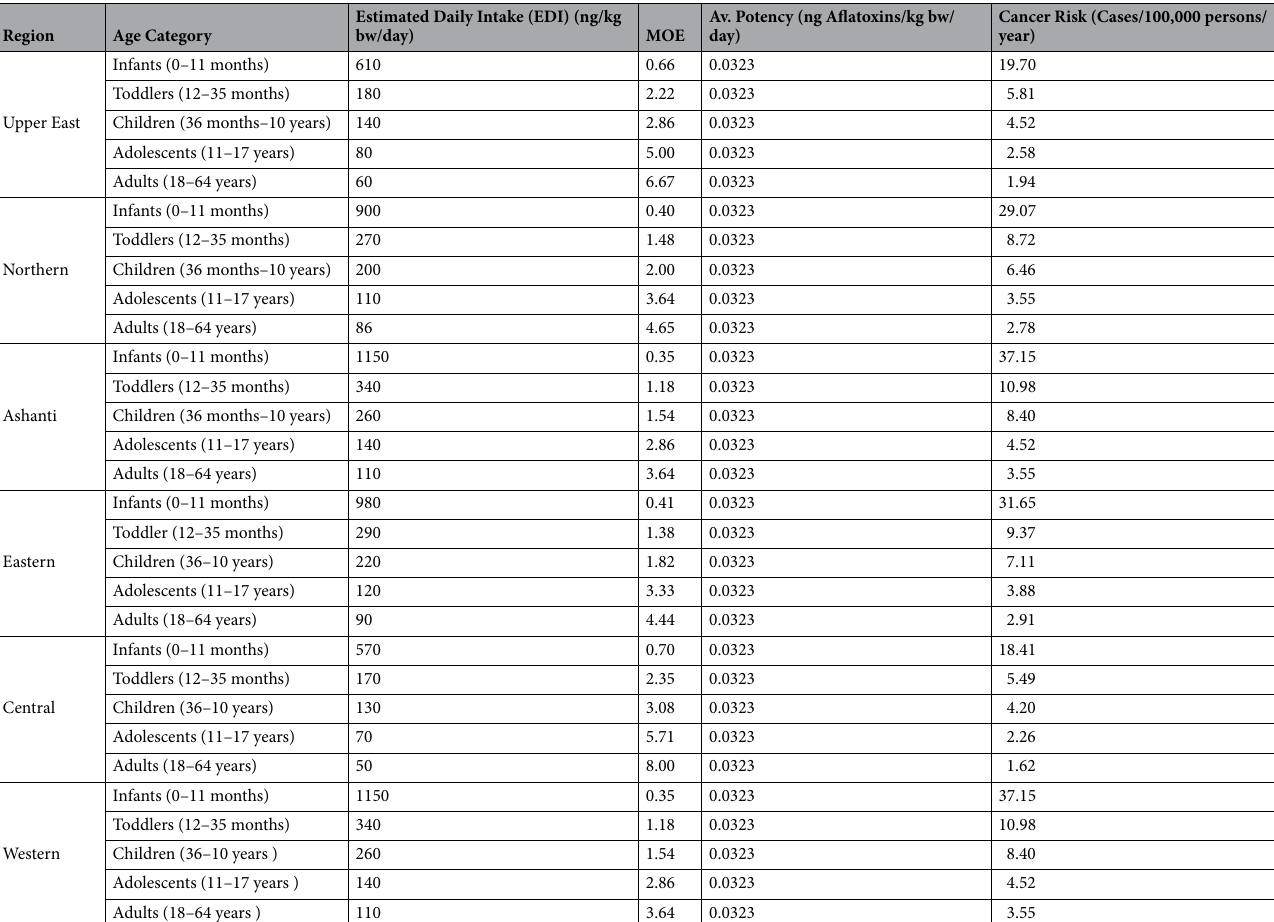
Table 16. Evaluation of risk for Total Aflatoxins via consumption of maize. Margin of Exposure-MOE. Mean aflatoxins- Upper East = 32.84 µg/kg, Brong = 48.93 µg/kg, Ashanti = 62.37 µg/kg, Eastern = 53.14